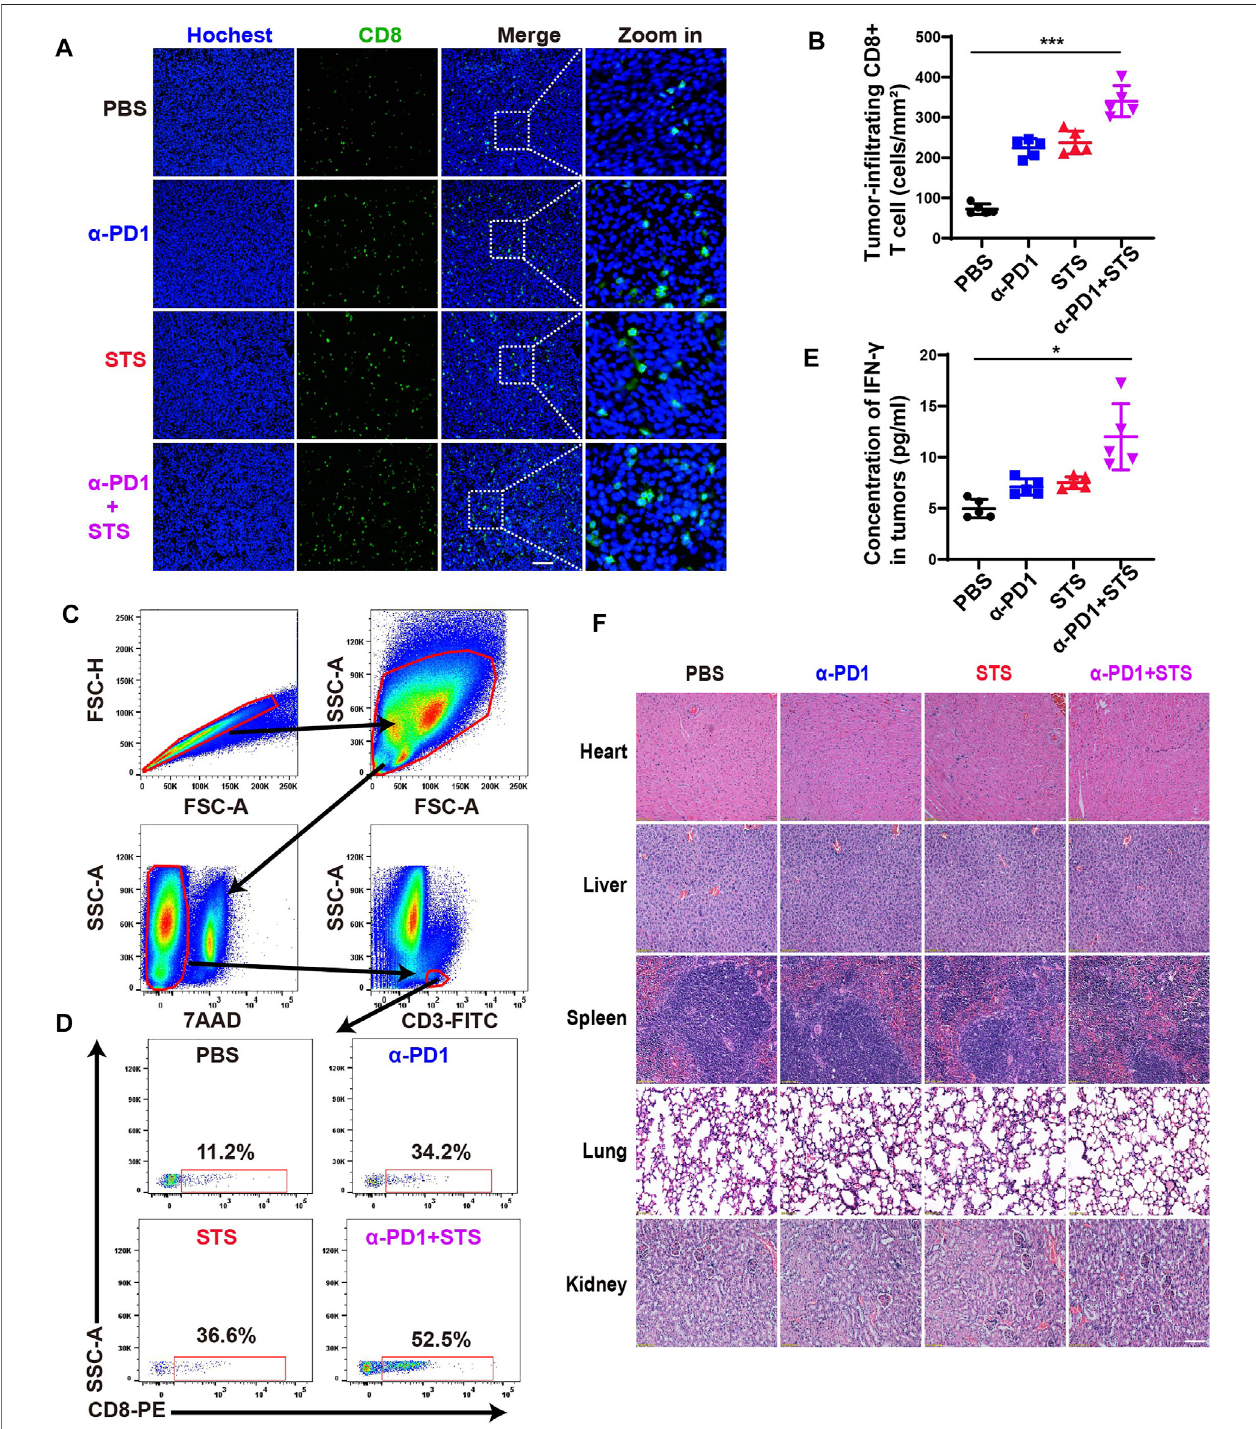
FIGURE 5 | STS improved the therapeutic effect of anti-PD1 by increasing the number of CD8 + T cells and the concentration of IFN- γ in tumors. (A) Immuno fl uorescence analysis of tumor-in fi ltrating CD8+ T cells after therapy. Scale bar: 100 μ m. (B) Statistical analysis of the number of CD8+ T cells in each group under a microscope at 200x magni fi cation. (C,D) The percentage of CD8+ T lymphocytes in all CD3+ T cells in tumors after therapy. (E) The concentration of IFN- γ in tumortissues.ItwasdetectedbyELISA. (F) Hematoxylinandeosin(H&E)stainingofthemainorgansofmice.Scalebar:100 μ m.Statisticaldataarerepresentedas the mean ± SD. * p < 0.05 and *** p < 0.001 analyzed by ANOVA.